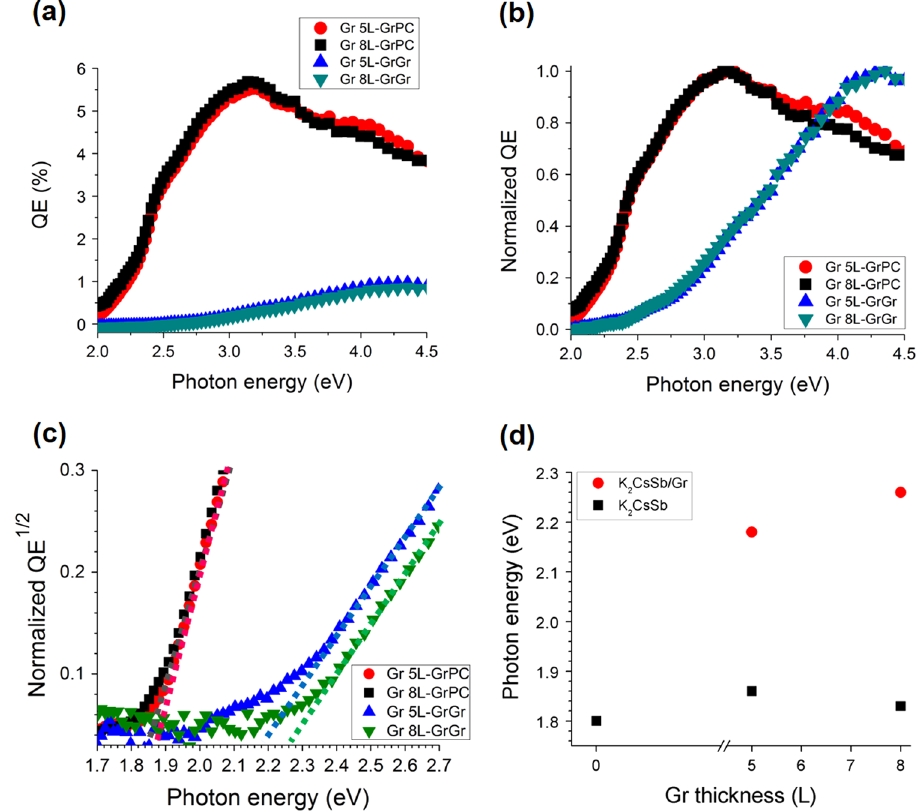
Fig. 4 QE spectral response based on photoemission from the PC and graphene (Gr) sides of the fi lms. GrPC indicate photoemission measured in a Gr-in, PC-out con fi guration and GrGr in a Gr-in, Gr-out con fi guration. a QE (%) vs. incident photon energy. b QE normalized to the highest value from the PC side. c Photon energy cutoff indicating the work function. Extrapolating lines are shown in dash . d Work function of the PCs deposited on the graphene substrate with different thicknesses. Gr thickness = 0 is for PC deposited on SS as a